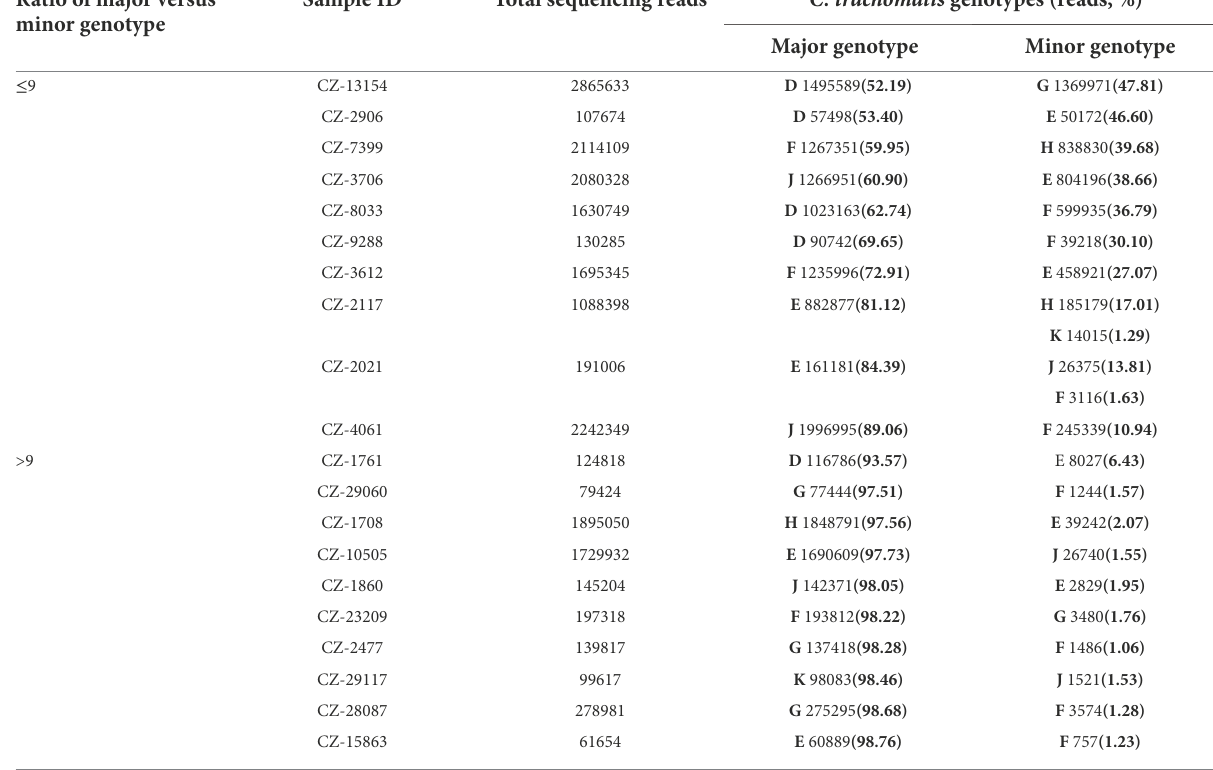
TABLE 2 Composition of C. trachomatis genotypes in 20 specimens of mixed-genotype infections using high-throughput sequencing in Chenzhou, China during 2019 and 2021. Ratio of major versus Sample minor genotype